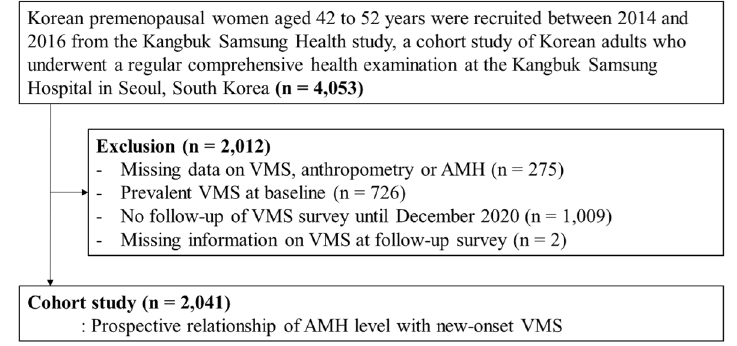
Figure 1. Flowchart of study